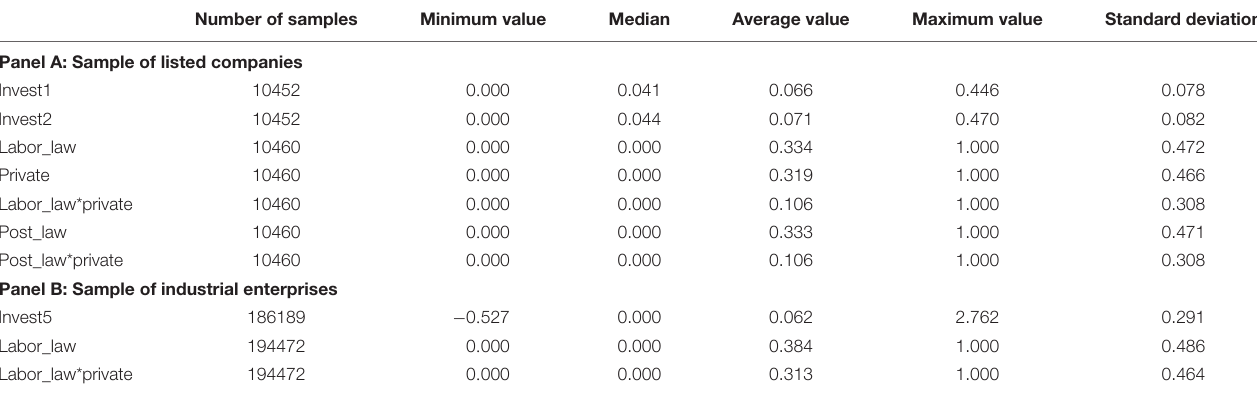
TABLE 1 | Descriptive statistics of main variables.